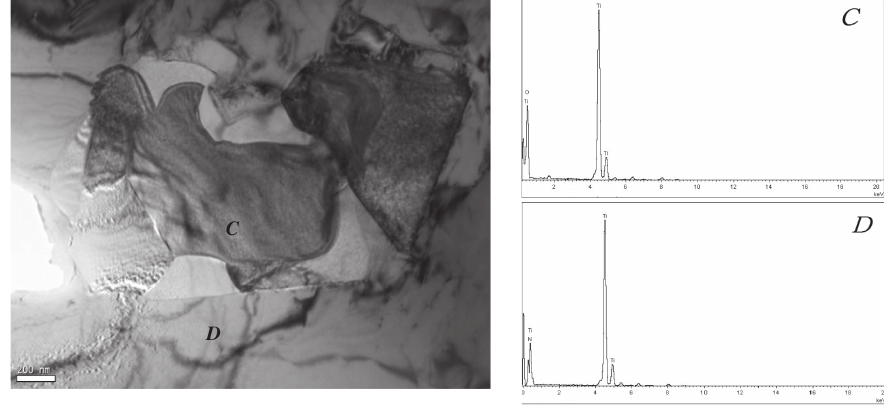
Figure 7: Morphology in the bright-field image of precipitate.